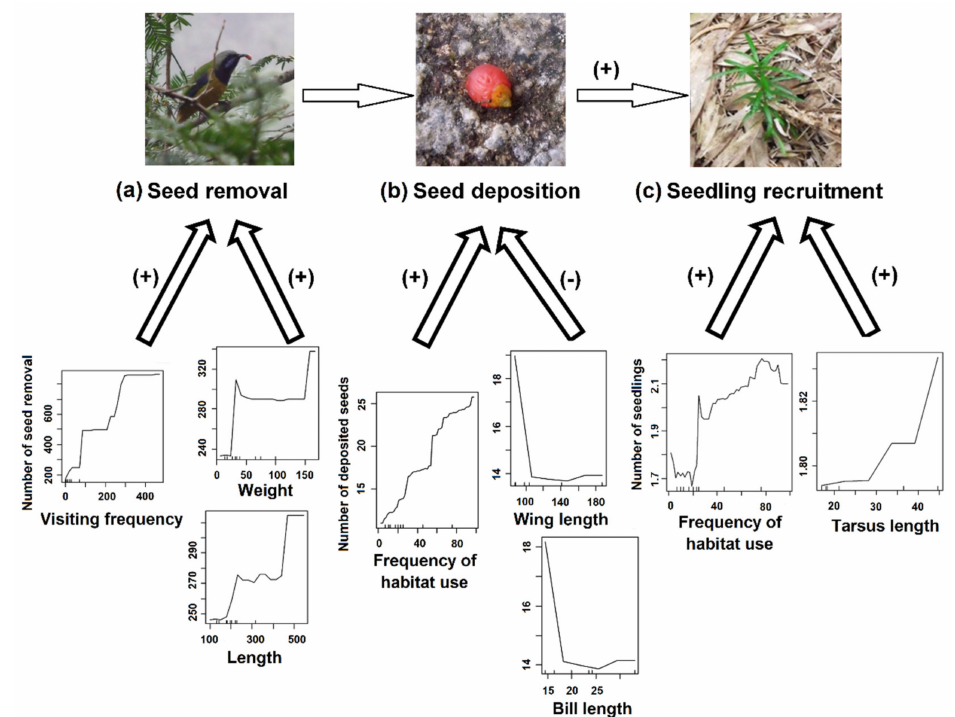
Figure 3. A machine-learning algorithm, random forest, for testing the e ff ects of bird traits on ( a ) seed removal, ( b ) seed deposition, ( c ) seedling recruitment for Taxus chinensis (Pilger) Rehd across the in-situ and ex-situ sites, Southeast China.